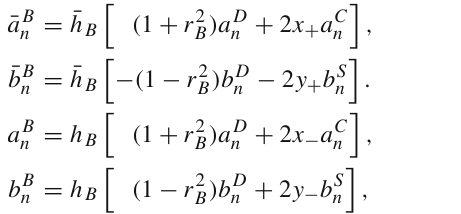
is arbitrary, the coefficients are normalised such that a D